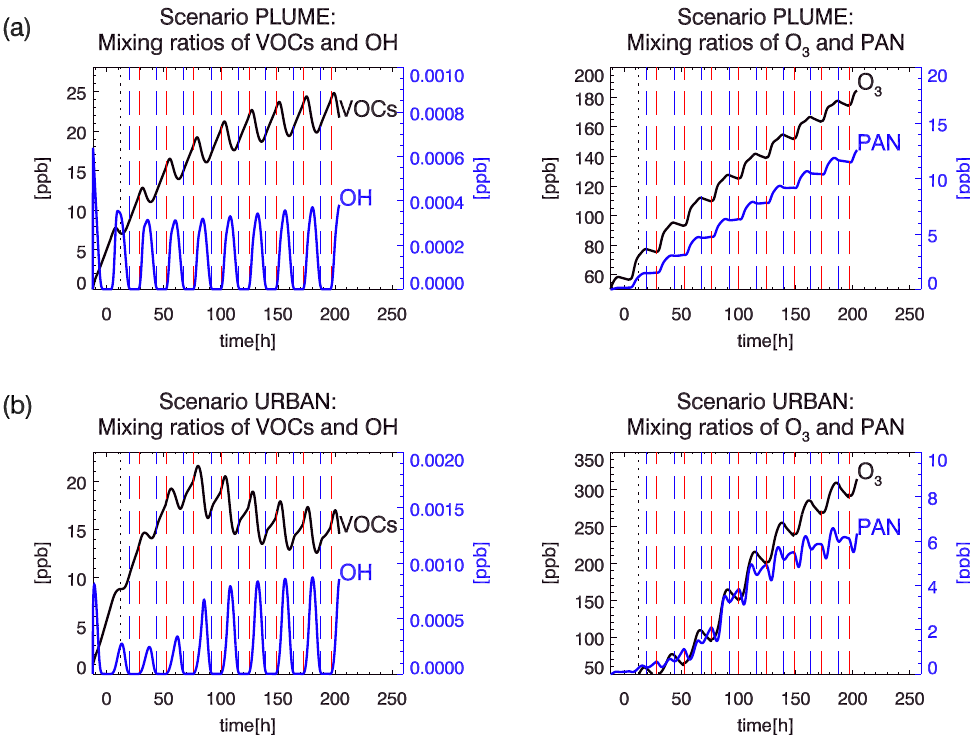
Fig. 2. Time dependence of the OH, VOC (left panel column), O 3 and PAN (right panel column) mixing ratios for scenarios (a) PLUME and (b) URBAN. Here, 12:00 corresponds to the starting time, t 0 , of the first singular vector calculation (2 July, 12:00), and 204h corresponds to the final time, t F , of the last singular vector calculation (10 July, 12:00). Hence mixing ratios for all considered initial times, t I , and final times, t F , of the TSVD are depicted. To aid interpretation, sunrises are marked with dashed red lines and sunsets with dashed blue lines, respectively.